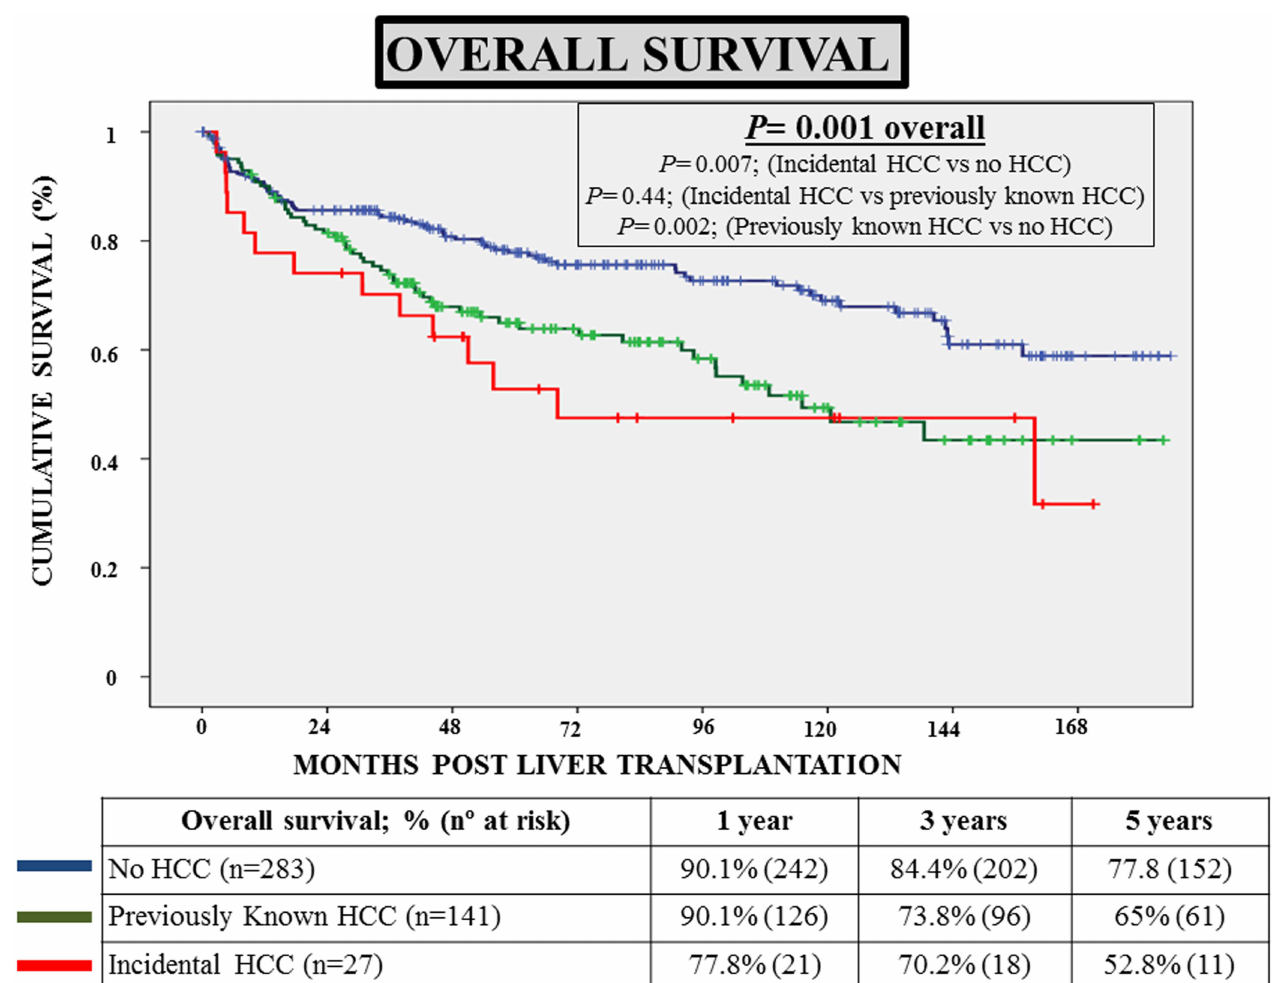
Fig 1. Survival curves showing overall survival of patients with incidental hepatocellular carcinoma (n = 27), as compared with patients with previously known hepatocellular carcinoma (n = 141), and patients without hepatocellular carcinoma (n = 283).